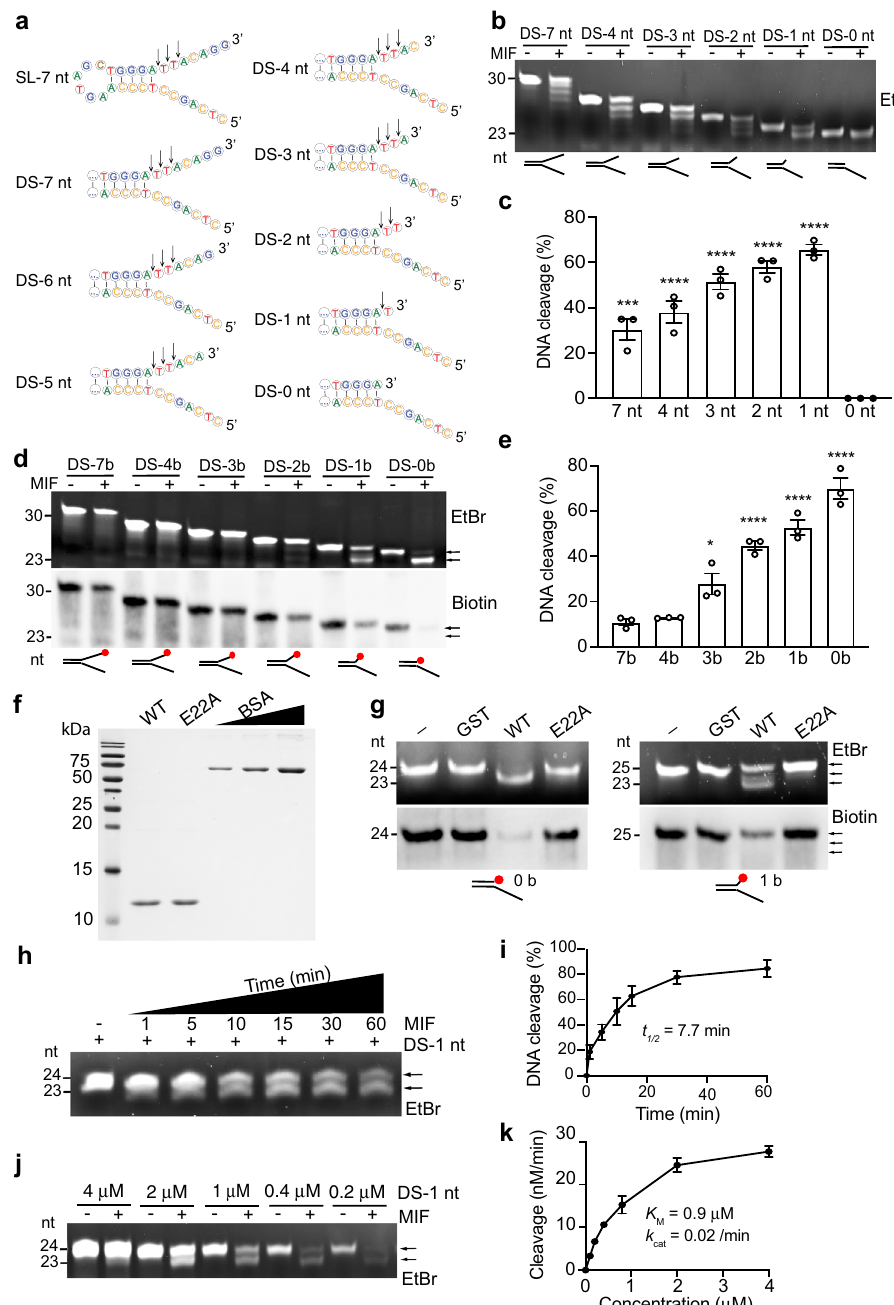
Fig. 1 MIF recognizes Y-shaped dsDNA and cleaves 3 ’ unpaired nucleotides. a Second structure of MIF substrates ssDNA with the stem-loop (SL) and Y- shaped dsDNA with different lengths of unpaired nucleotides at the 3 ′ end. b , c In vitro MIF (2 μ M) nuclease cleavage assay using Y-shaped dsDNA as substrates. Data were quanti fi ed in c (mean ± SEM, n = 3 biologically independent experiments). **** P < 0.0001, *** P < 0.001; by one-way ANOVA Dunnett ’ s multiple comparisons test vs 0 nt group. EtBr ethidium bromide. d , e In vitro MIF (2 μ M) nuclease cleavage assay using 3 ′ biotin-labeled Y- shaped dsDNA as substrates. Data were quanti fi ed in e (mean ± SEM, n = 3 biologically independent experiments). **** P < 0.0001, * P < 0.05; by one-way ANOVA Dunnett ’ s multiple comparisons test vs 7b group. Red dot indicates biotin ( d ). Arrow indicates the cleavage products. f Protein puri fi cation of wild- type (WT) MIF and nuclease-inactive E22A mutant shown by Coomassie blue staining. BSA (0.5 – 3 μ g) was used as control. g In vitro nuclease assay of MIF and E22A mutant (2 μ M) using 3 ′ biotin-labeled Y-shaped dsDNA (0.8 μ M) as substrates. h , i MIF (2 μ M) cleaves DS-1 nt substrate (0.8 μ M) in a time (1, 5, 10, 15, 30, 60 min)-dependent manner. Representative image is shown in h . Data are quanti fi ed in i (mean ± SEM, n = 3 biologically independent experiments). j , k MIF (2 μ M) cleaves DS-1 nt substrate in a concentration (0.2, 0.4, 1, 2, 4 μ M)-dependent manner. Representative image is shown in j . Data are quanti fi ed in k (mean ± SEM, n = 3 biologically independent